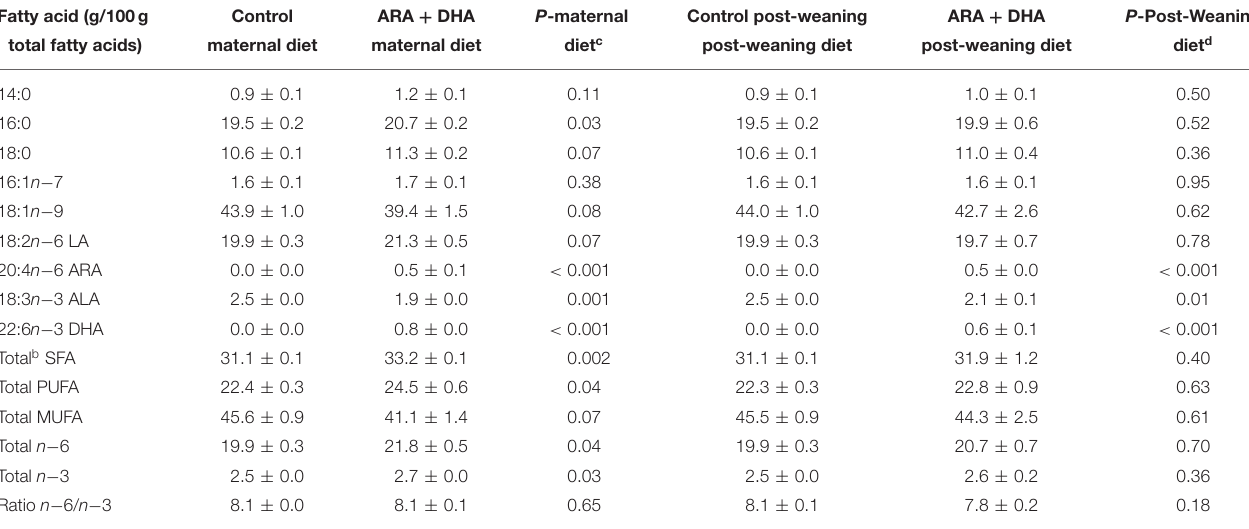
TABLE 1 | Total fatty acid composition of the experimental maternal diets fed during the suckling period and post-weaning diets fed to Brown Norway offspring a . Fatty acid (g/100g Control ARA + DHA P -maternal Control post-weaning total fatty acids) maternal diet maternal diet diet c post-weaning diet post-weaning diet diet